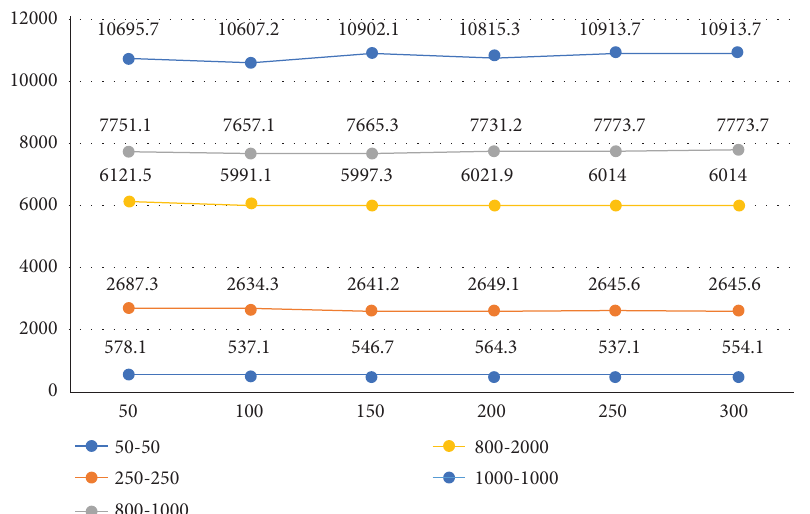
Figure 12: Kinetic energy (KE) tuning.